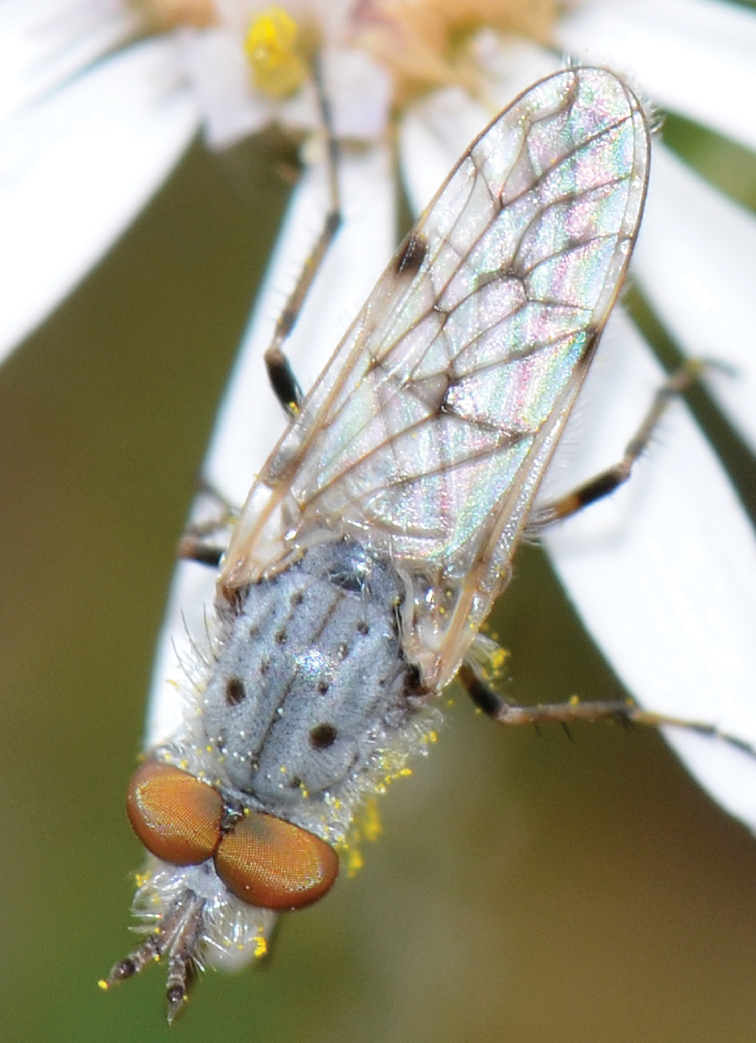
Medomega averyi sp. n., male, Western Australia, Stratton. Body length = 7.0 mm. Photograph credit: Fred and Jean Hort